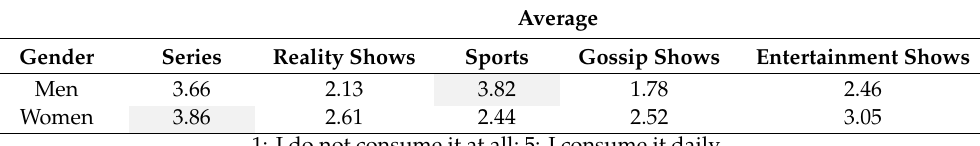
Table 11. Audiovisual product consumption according to gender